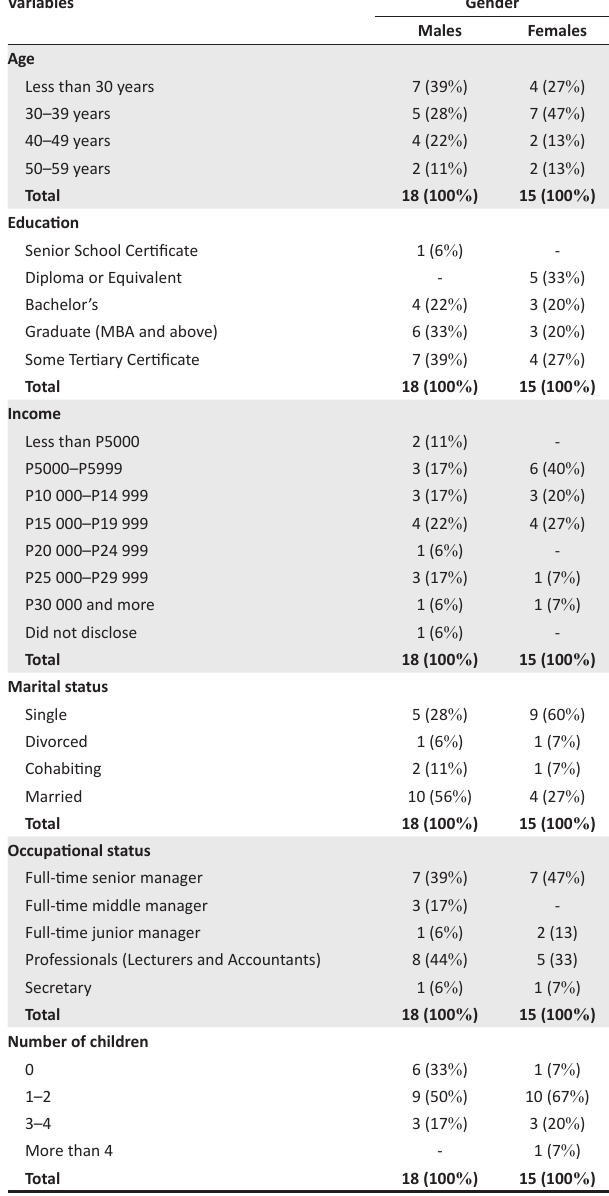
TABLE 1: Demographic characteristics of male and female